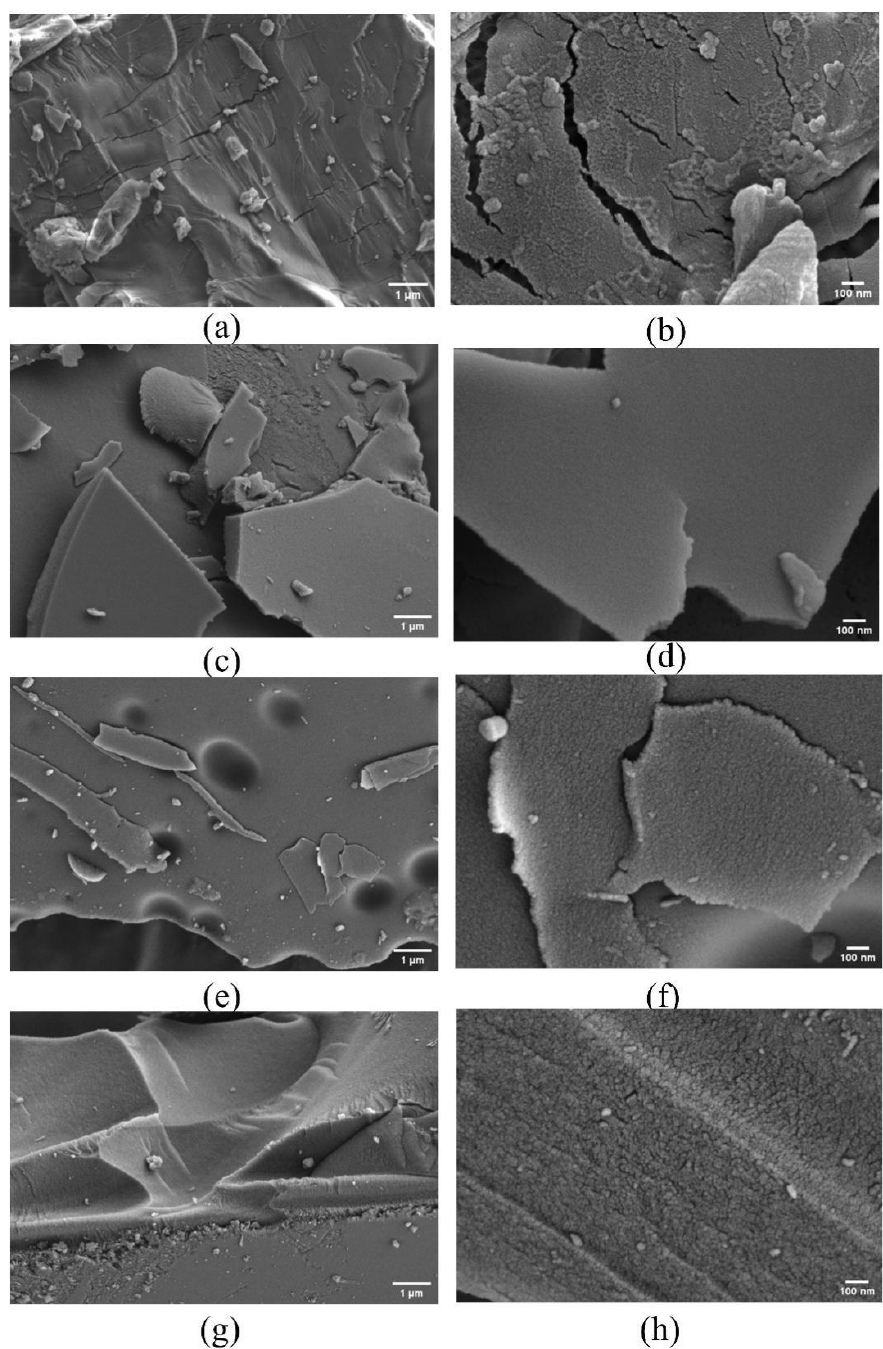
Figure 6. SEM images of β -CD samples (inactivated ( a , b ); activated at 400 ◦ C ( c , d ); activated at 600 ◦ C ( e , f ); activated at 800 ◦ C ( g , h